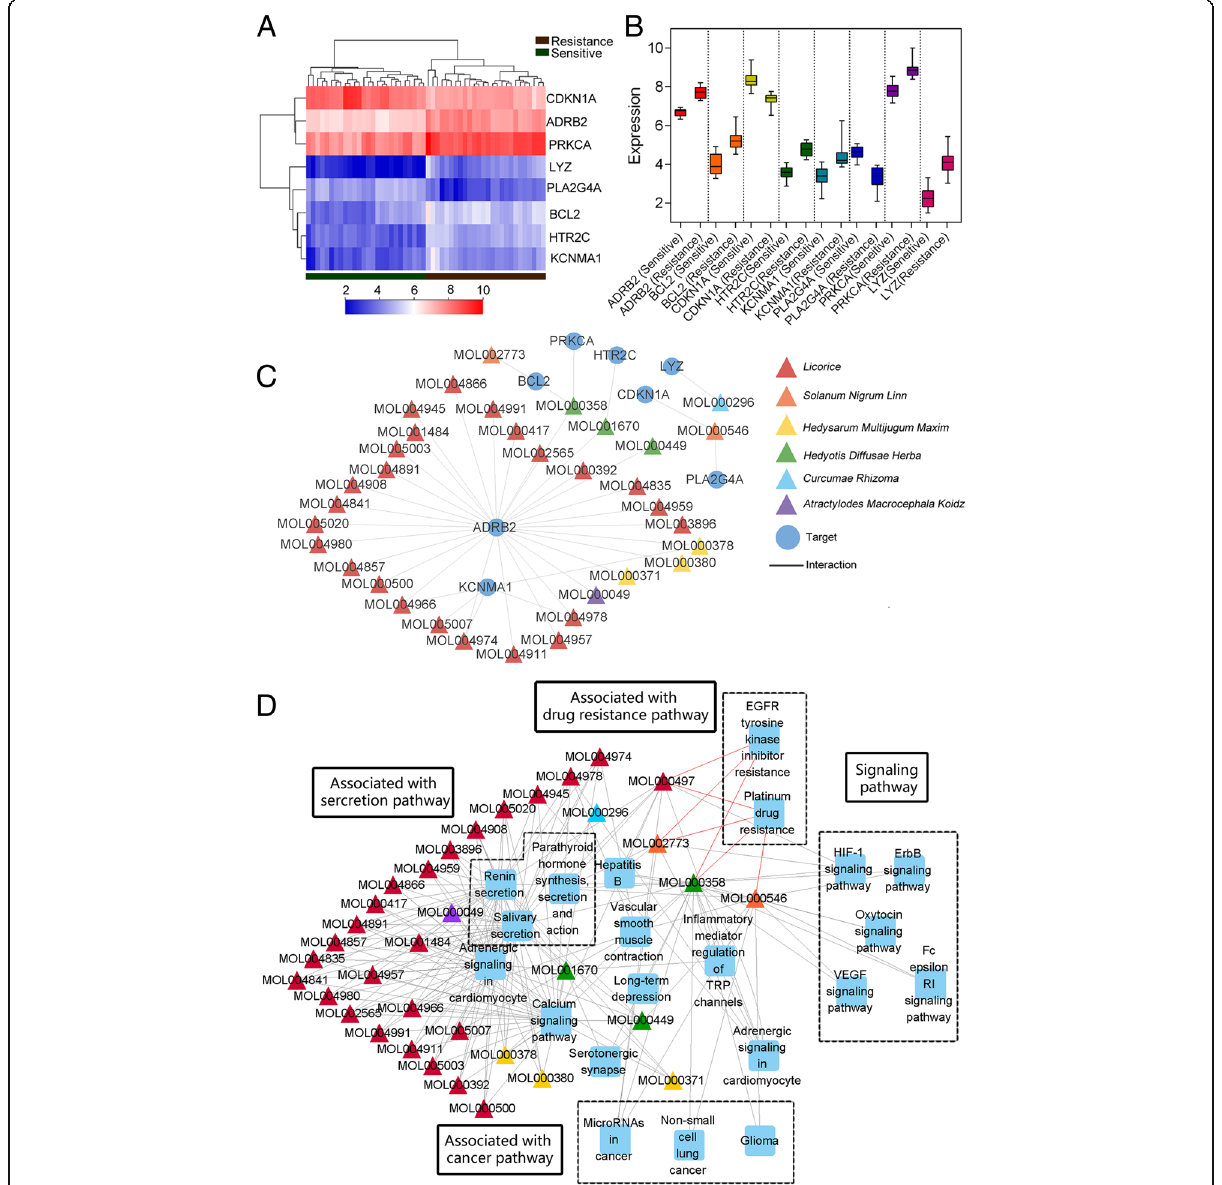
Fig. 4 Expression of core genes and subnetwork of core genes. a Heatmap of core genes in EGFR-TKI resistance and sensitive groups. b boxplot of each core gene between two groups. c Subnetwork of compounds and targets. The triangles represent different compounds and different color represent herbs that include the compounds. d The compound-pathway interaction network is constructed by compound and the pathway that consisted of core targets. Red lines represent compounds directly related to drug